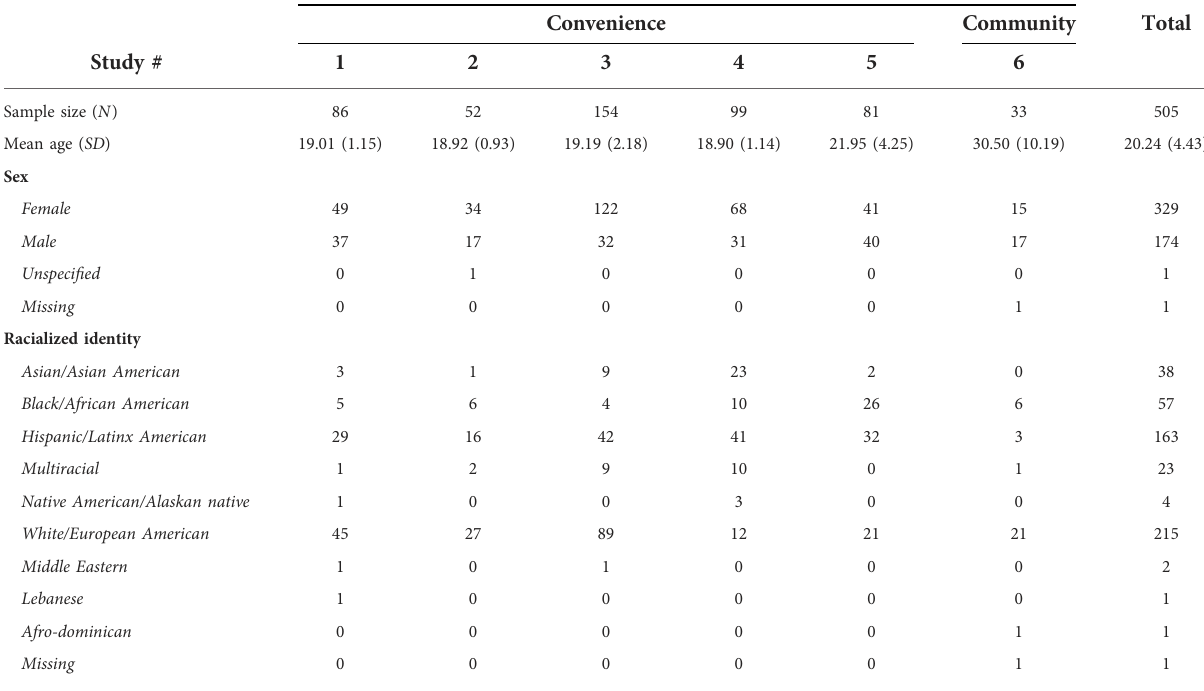
TABLE 1 Sample descriptive characteristics by